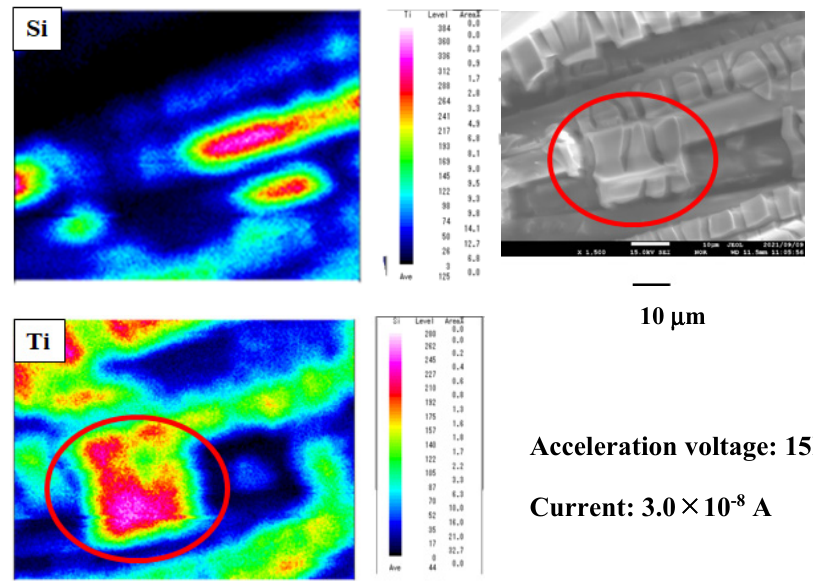
Figure 1 . SEM and EPMA images of TiO 2 film, which is coated on netlike glass disc. Figure 1. SEM and EPMA images of TiO 2 film, which is coated on netlike glass